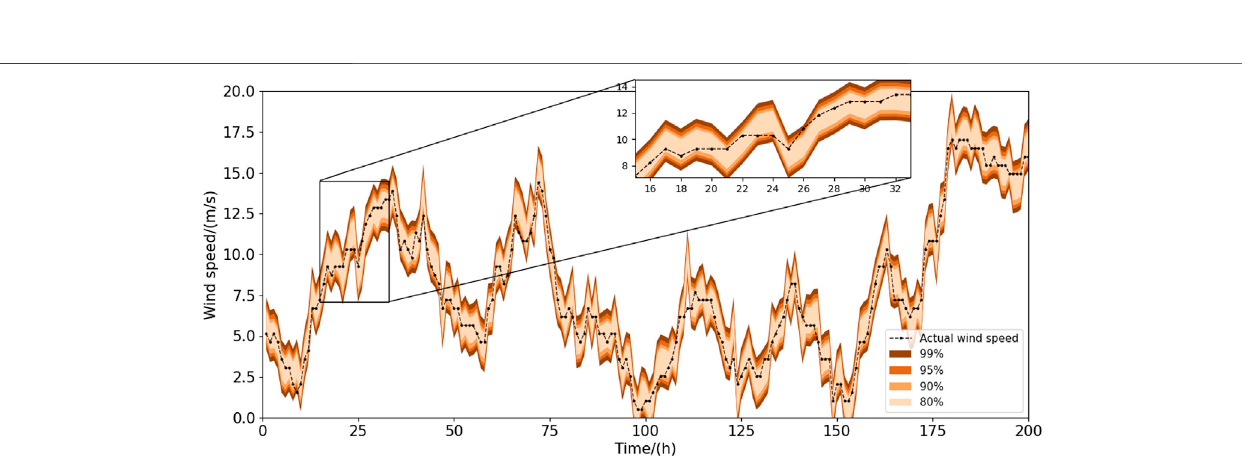
FIGURE 13 | Interval prediction of different con fi dence within autumn.